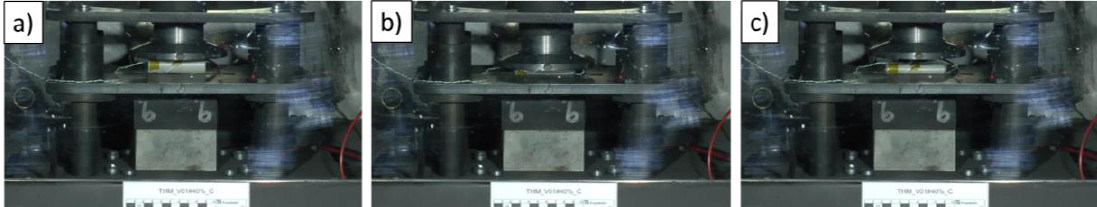
Figure 6. Experiment: Flat compression with v = 10 mms −1 of cell with SoC of 40%. ( a ) first contact between flat impactor and batterie. ( b ) maximum intrusion and ( c ) end of test, impactor is moving upward.